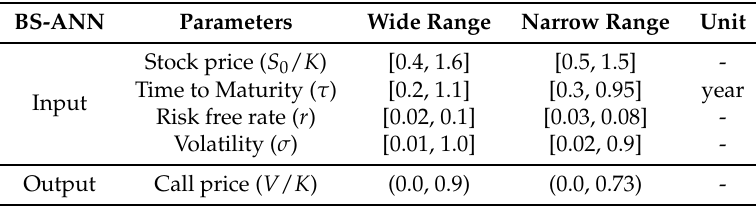
Table 4. Wide and narrow Black-Scholes parameter ranges.